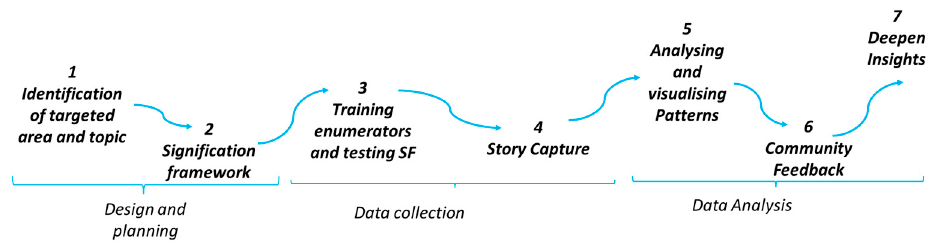
Figure 4. The SenseMaker ® Process.